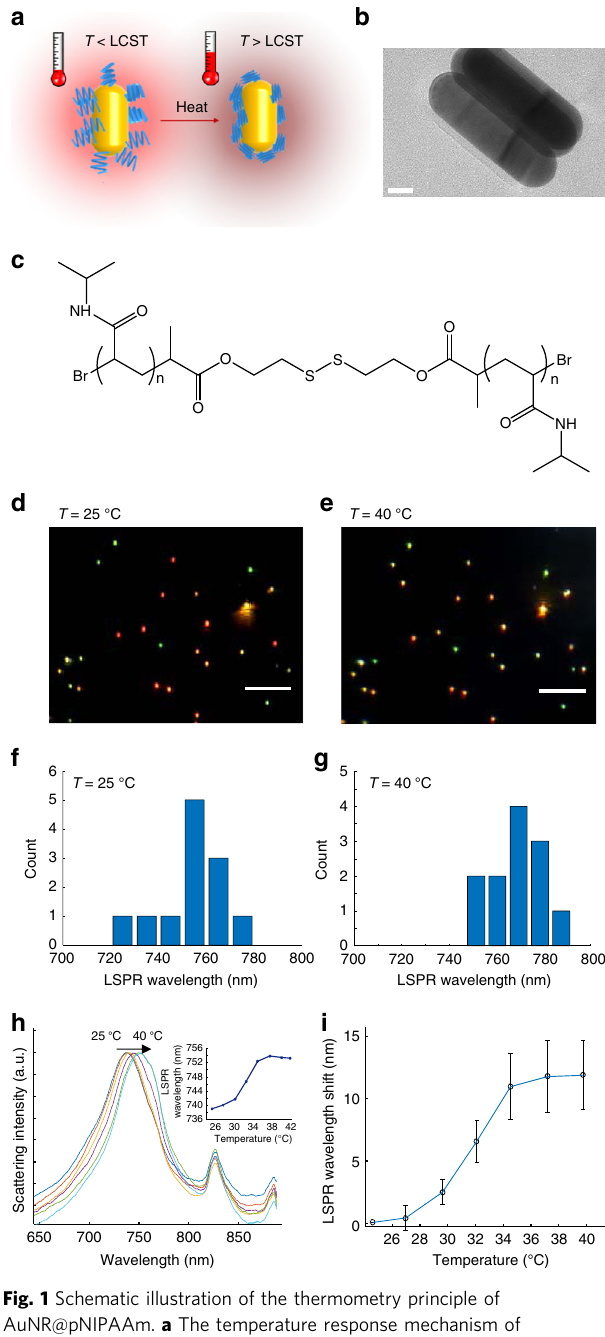
Fig. 1 Schematic illustration of the thermometry principle